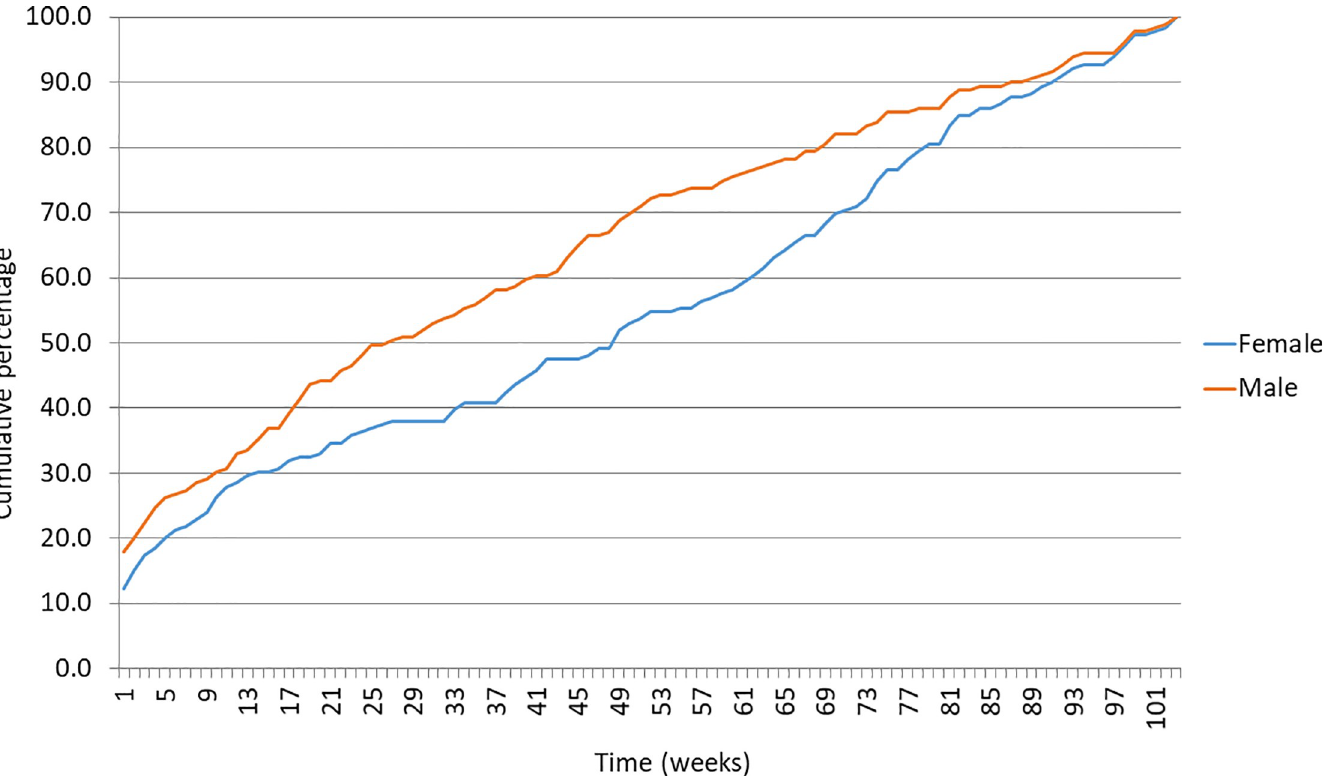
Fig 4. The cumulative probability of the first repetitive DSP event during the first two years, among males and females. Percentages of repetitive events occurred in each week after the index event.